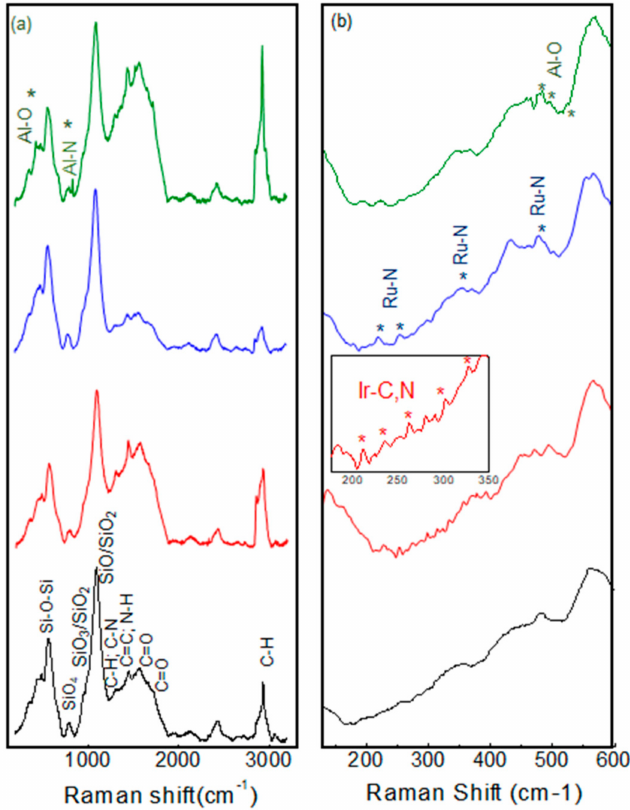
Figure 8. Raman spectra of biosilica shells isolated from bare diatoms (grey line), Ir-(red line), Ru- (blue line), and Al-(green line) doped diatoms. (*) indicate metal-C and/or metal-N bands. ( a ) Long range spectra; ( b ) focus on low